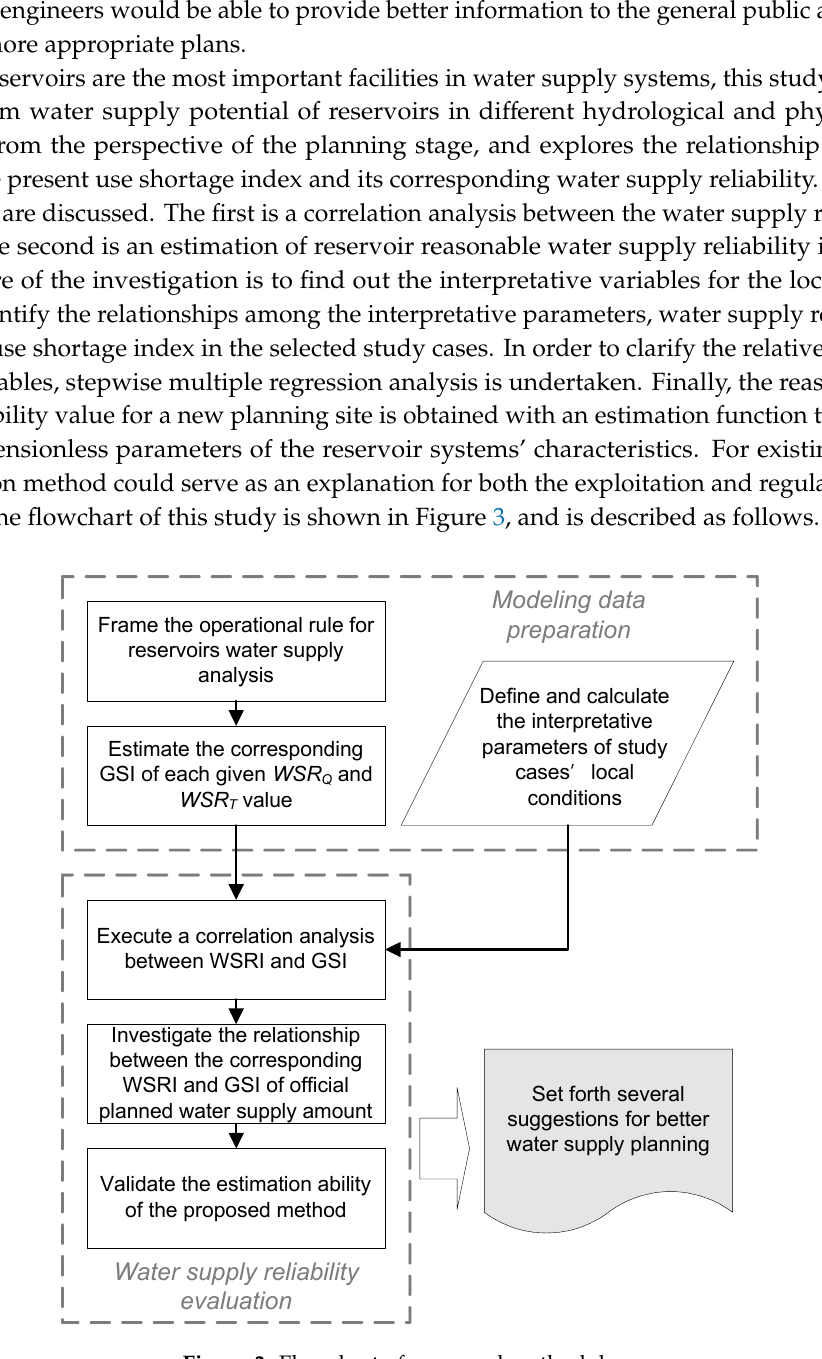
Figure 3. Flowchart of proposed methodology.